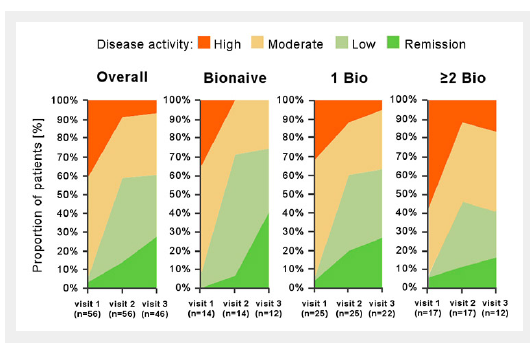
Disease state over time as assessed by physicians shown for the overall population, for biologic-naïve patients, and for patients with one (1 Bio) or at least two (≥2 Bio) previous biologics. Numbers in brackets indicate the numbers of patients (n) with available physicians’ assessment at each